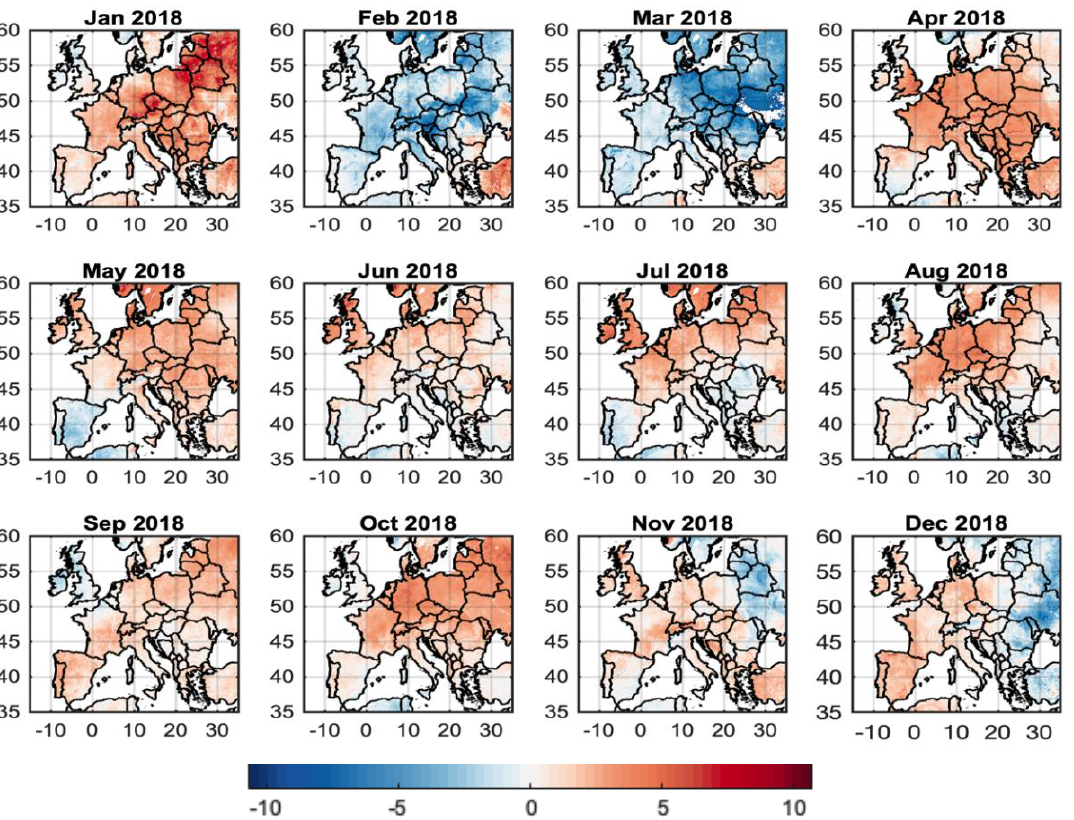
Figure 3. Monthly anomaly values of MSG LST during 2018 over Europe, with respect to 2004–2019.